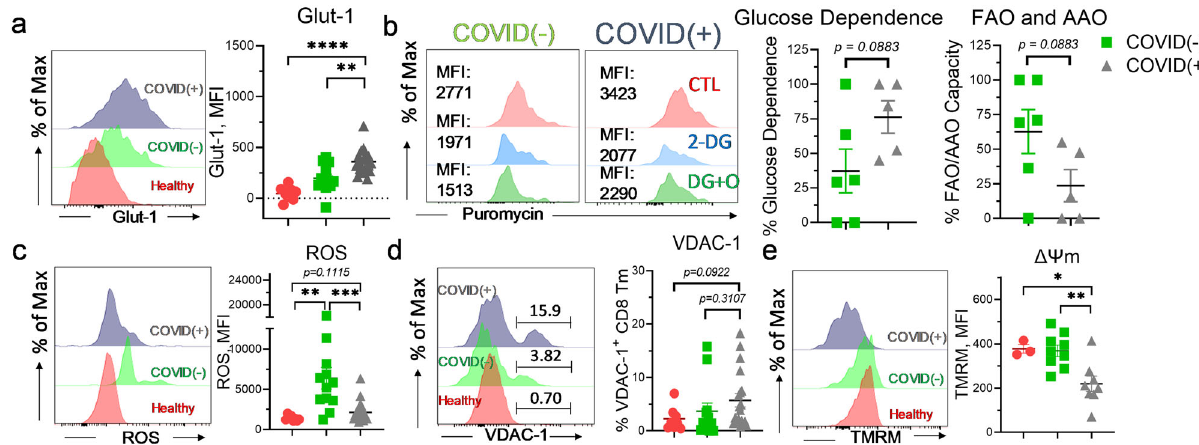
Fig. 5 Metabolic reprogramming towards anaerobic glycolysis upon mitochondrial dysfunction in CD8 + T M during SARS-CoV-2 infection. Freshly isolated PBMCs were evaluated for metabolic analysis using fl ow cytometry. a Representative histogram and summary graphs demonstrating glut-1 expression in CD8 + T M from healthy, COVID( − ), and COVID( + ) patients ( n = 8 HD, 12 C − , 19 C + ). b Representative histograms and dot plot graphs demonstrating glucose dependence and FAO/AAO capacities of CD8 + T M from healthy, COVID( − ), and COVID( + ) patients by the SCENITH assay (n = 6 C − , 5 C + ). c – e Representative histogram and summary graphs demonstrating the expression of ROS ( n = 8 HD, 12 C − , 19 C + ) ( c ), abundance of vdac + CD8 + Tc ( n = 8 HD, 12 C − , 19 C + ) ( d ), and mitochondrial membrane potential ( n = 3 HD, 9 C − , 8 C + ) e in CD8 + T M from healthy, COVID( − ), and COVID( + ) patients. b , e three samples were excluded due to critically low CD8 + T M count; in ( a , c , d ), one sample was excluded due to critically low